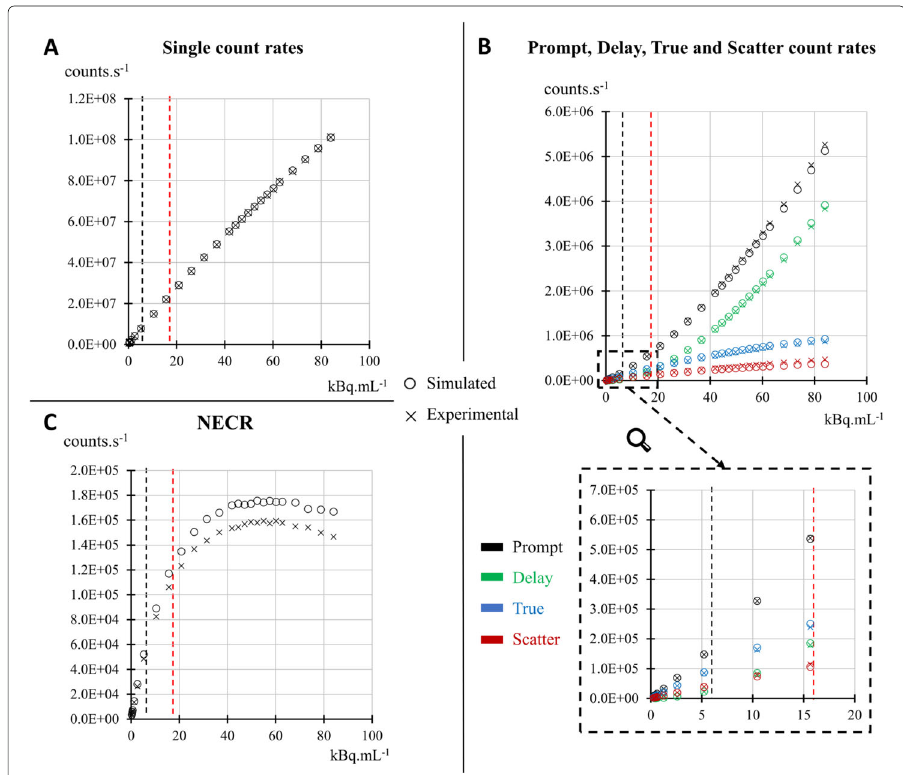
Fig. 3 Simulated and experimental count rates according to activity concentrations. a Single count rates. b Prompt, delay, true, and scatter count rates. c NECRs. The vertical dashed lines correspond to the upper level of activity concentrations usually used in clinical routine for 18 F (black line) and 82 Rb (red line) PET exams